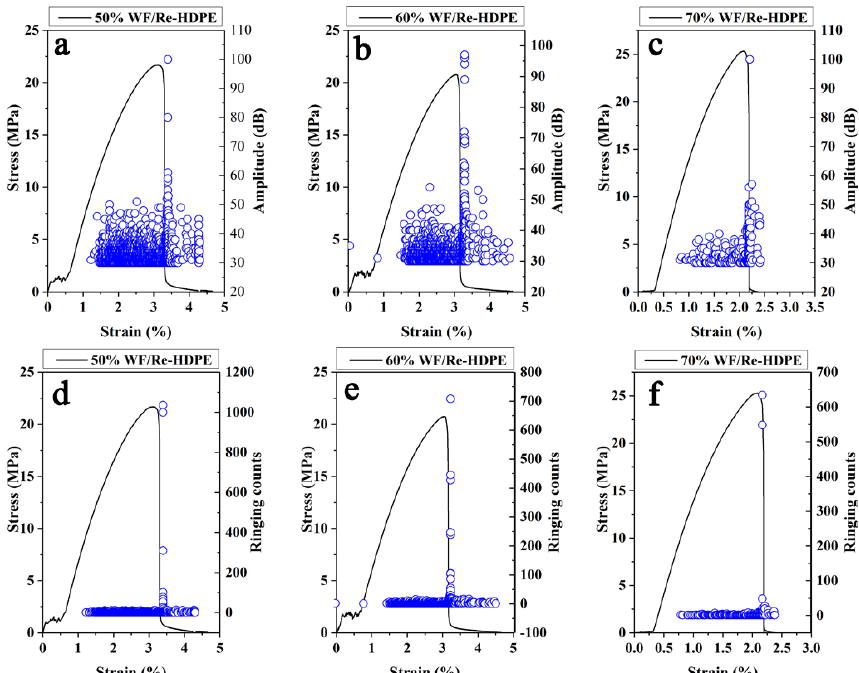
Figure 6. The AE amplitude, ringing counts, and stress-strain curves of wood fiber (WF)/recycled high density polyethylene (Re-HDPE) composites with different WF contents. The blue circle represents amplitude and ringing counts in ( a – f ), respectively.